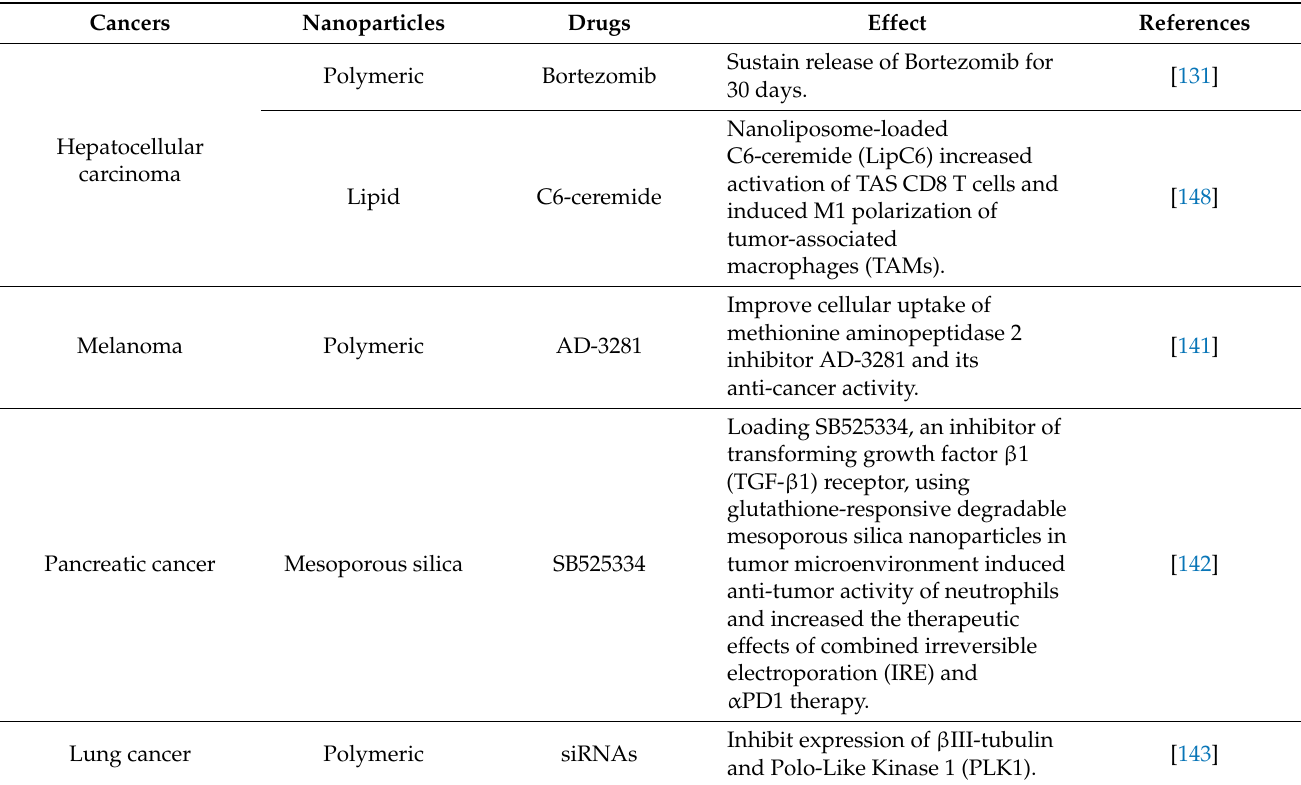
Table 4. Nanoparticles for drug delivery in cancer